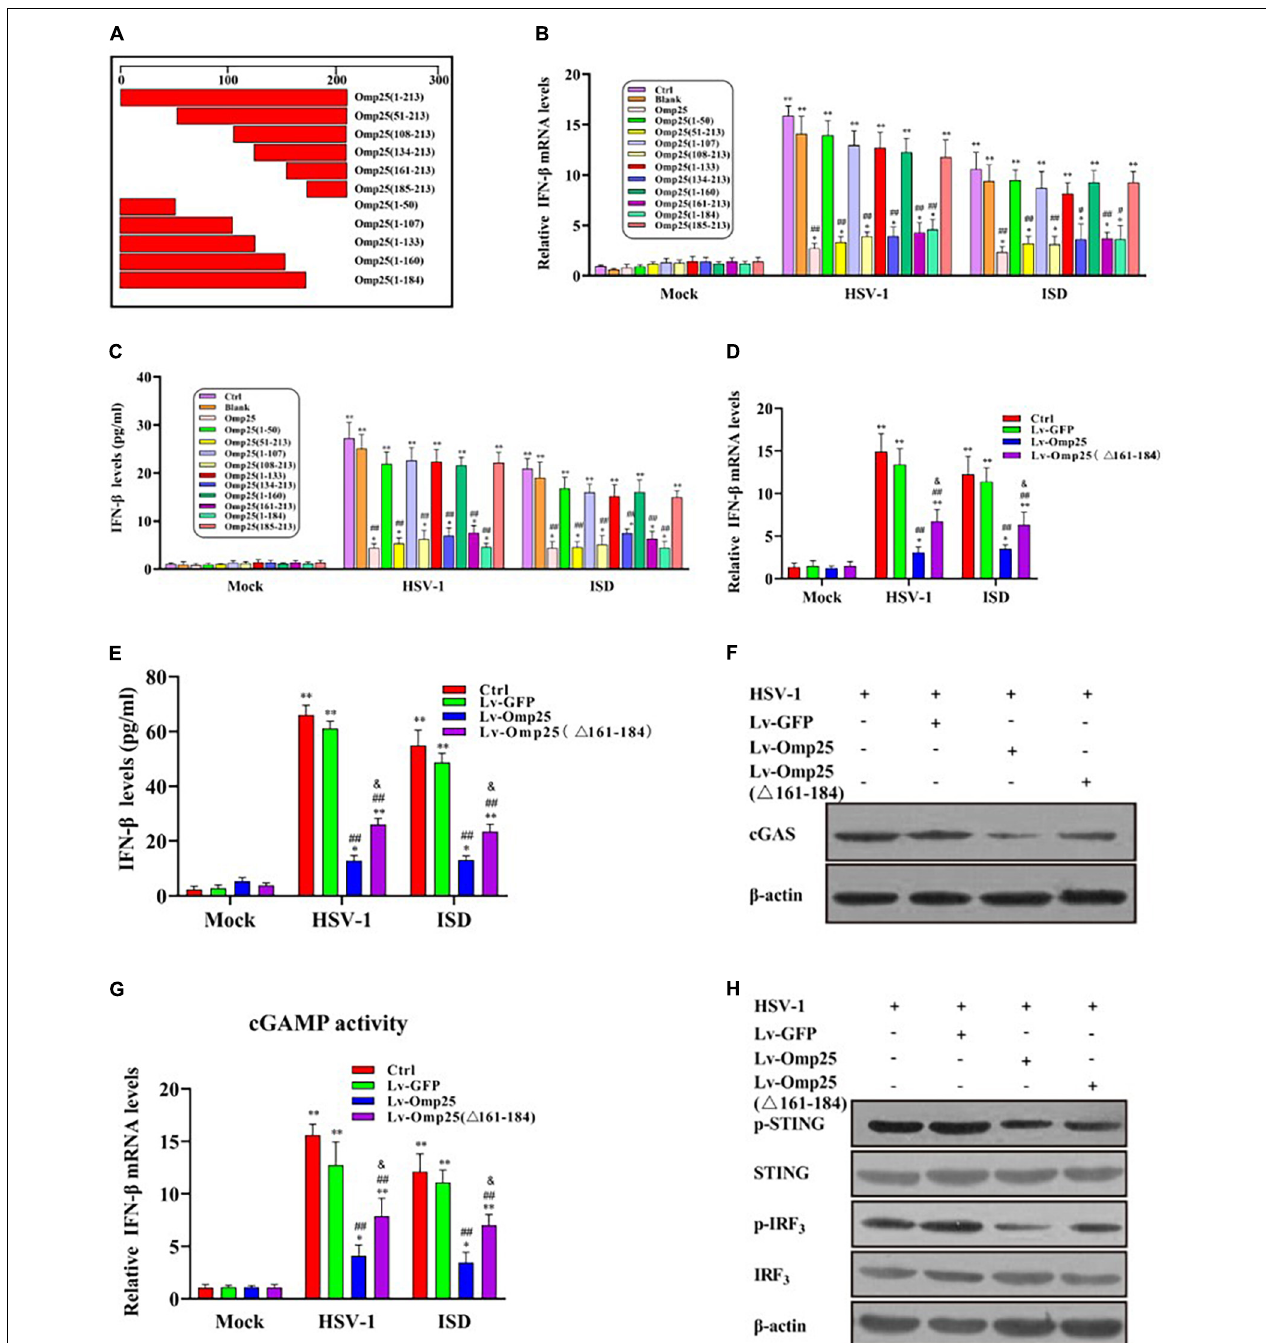
FIGURE 7 | Effect of Omp25 deletion mutants on cGAS in cells. (A) Schematic diagram of Omp25 deletion mutants. (B,C) Mapping regions of Omp25 that decrease IFN- β mRNA levels or protein levels. RAW264.7 cells were infected with different deletion mutants for 48 h, then infected with HSV-1 (10 MOI) or transfected with ISD (2 µ g/ml) for another 6 or 24 h. Cells were harvested and subjected to qRT-PCR analysis or ELISA analysis to examine expression of IFN- β . (D,E) Lv-Omp25 (cid:49) 161–184 showed an attenuated inhibitory effect in transcription and expression of IFN- β . RAW264.7 cells were infected with Lv-Omp25, Lv-Omp25 (cid:49) 161–184, or Lv-GFP for 48 h, then infected with HSV-1 (10 MOI) or transfected with ISD (2 µ g/ml) for another 6 or 24 h. Cells were harvested and subjected to qRT-PCR analysis or ELISA analysis to examine expression of IFN- β . (F,G) Omp25 (cid:49) 161–184 showed a weak inhibitory effect on levels of cGAS and production of cGAMP. Cells were treated as in panels (D,E) ; protein levels of cGAS and levels of cGAMP in cell extracts were measured by Western blotting or qRT-PCR as described in section “Materials and Methods.” (H) Lv-Omp25 (cid:49) 161–184 showed a weakened inhibitory effect on phosphorylation of STING and IRF3. Cells were treated as in panels (D,E) , and phosphorylation of STING and IRF3 were measured by Western blotting. * P < 0.05, ** P < 0.01 versus mock group, # P < 0.05, ## P < 0.01 versus Lv-GFP- infected cells in same groups, & P < 0.05 versus Lv-Omp25-infected cells in same groups.